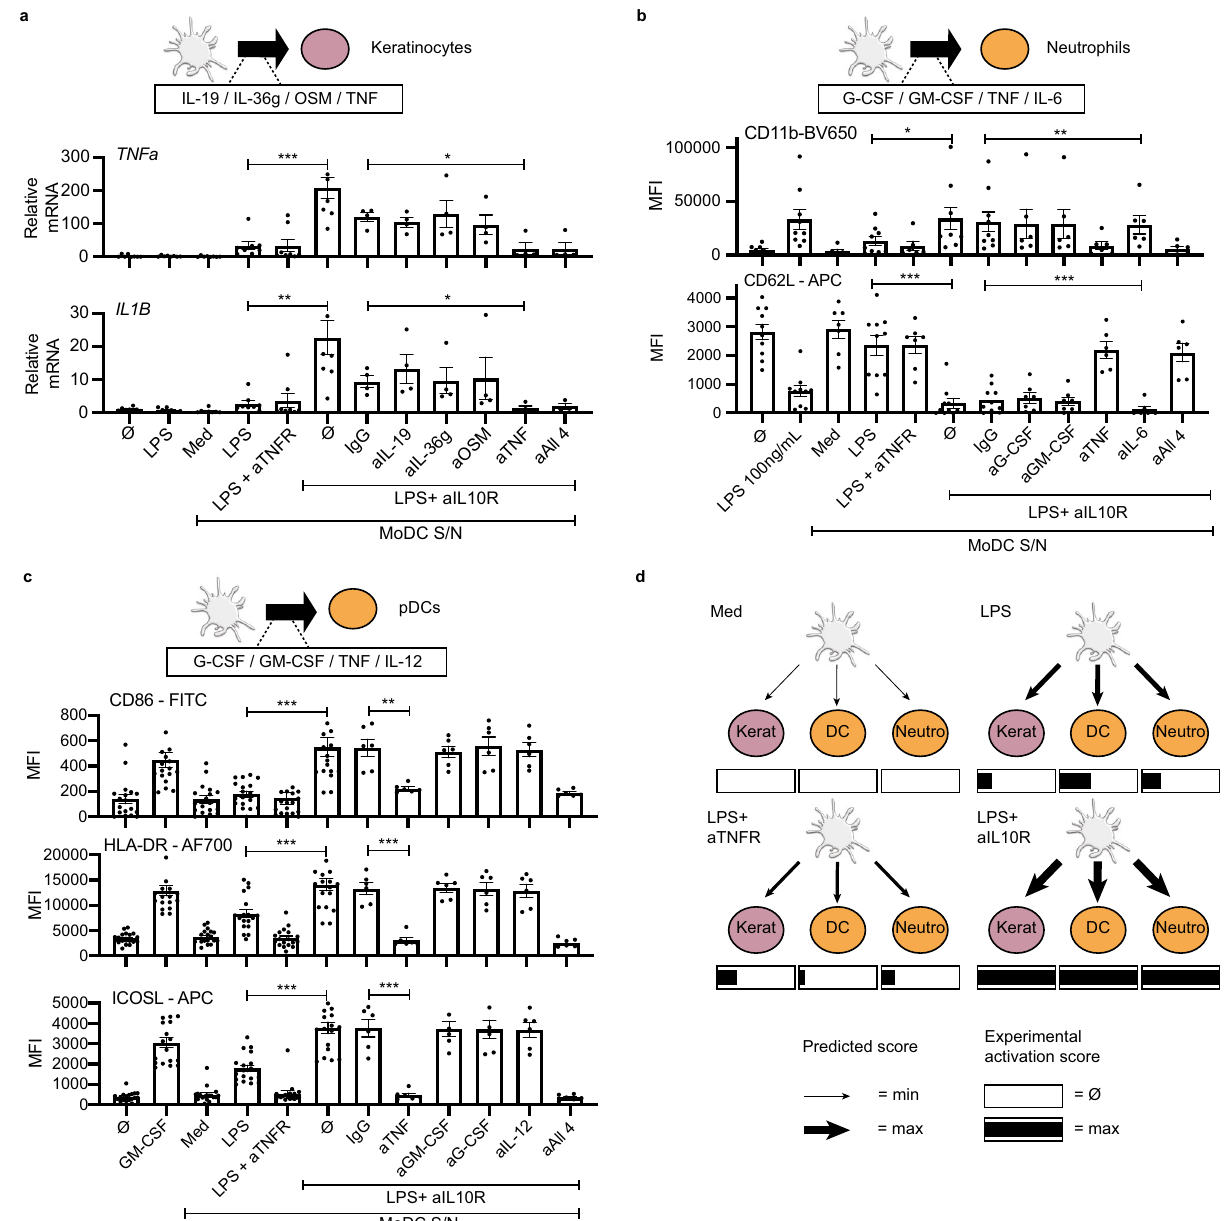
Fig. 7 IL-10 loop controls DC communication with keratinocytes, neutrophils, and pDCs. a RT-PCR analysis of the expression of TNF and IL-1b mRNA in HaCat cells incubated with medium, LPS or with supernatant (diluted 1:10) of the indicated DCs for 4 h. Blocking antibodies for the cytokines IL-19, IL-36g, OSM and TNF were added to LPS + aIL-10R-DC supernatant for 1-h incubation before culturing with HaCat cells. Data are represented as mean values ± SEM, n = 4 or n = 8 biologically independent samples depending on the conditions, * p < 0.05 (two-sided paired t -test without correction). b , c Expression of maturation markers CD86, HLA-DR, and ICOSL ( b ) or CD11b and CD62L ( c ) analyzed by fl ow cytometry with surface staining on pDCs ( n = 18 or n = 6 biologically independent samples depending on the conditions) cultured with supernatant (diluted 1:10) of the indicated DC for 24 h ( b ) and neutrophils ( n = 9 or n = 6 biologically independent samples depending on the conditions) ( c ) cultured with supernatant (diluted 1:100) of the indicated DC for 1 h. Blocking antibodies for the cytokines GCSF, GM-CSF, TNF, and IL-12 (for pDC) or IL-6 (neutrophils) were added to LPS + aIL-10R-DC supernatant for 1 h incubation before culture. Each biological replicate comprised independent DC donor paired to independent pDCs/neutrophils donor. Data are represented as mean values± SEM, * p < 0.05; ** p < 0.01; *** p < 0.001 (two-sided paired t -test without correction). d For each target cell, we reduced the different activation markers to a single parameter normalized between 0 (Ø) and 1 (max) in the rectangles. The value 0 corresponds to the activation level induced by supernatants from untreated DC, while 1 corresponds to the maximum activation level from all the observed conditions. These experimentally validated activation scores were in qualitative agreement with the ICELLNET communication scores between DC and the target cells, represented by the width of the edges. Some schematic art pieces were used and modi fi ed from Servier Medical Art, licensed under a Creative Common Attribution 3.0 Generic License. http://smart.servier.com/ ( a , b , c